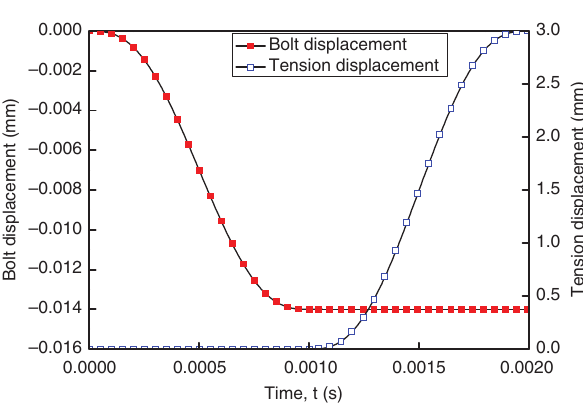
Figure 5: “Smooth” application of tensile displacement.